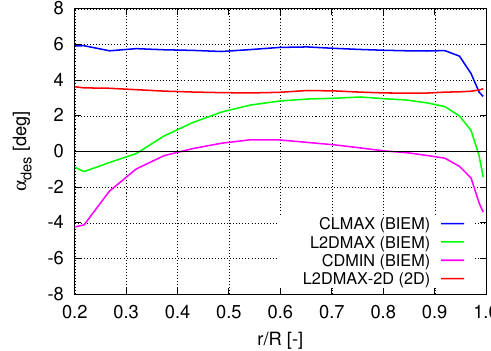
Fig. 10. Example of design AoA radial distributions as from Table I evaluated by BIEM-VFC and by X-Foil during the iterative proce-